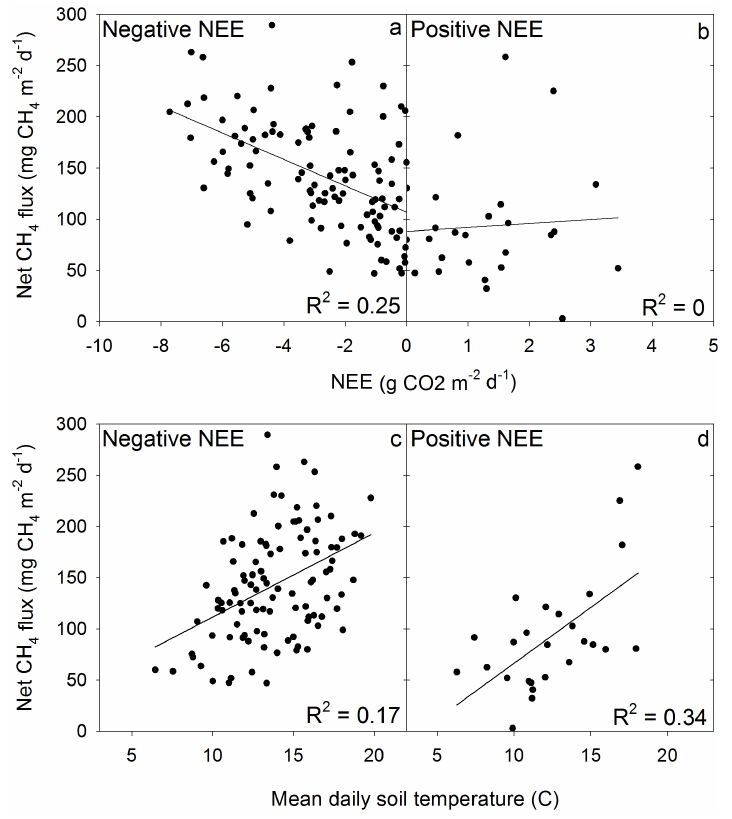
Fig. 7. The relationship between daily net ecosystem CO 2 exchange (NEE) (a, b) and mean daily air temperature (c, d) and net daily CH 4 fluxes for periods when daily NEE was negative (a, c) and positive (b, d) . Positive NEE and CH 4 flux values represent fluxes to the atmosphere and negative values represent losses from the